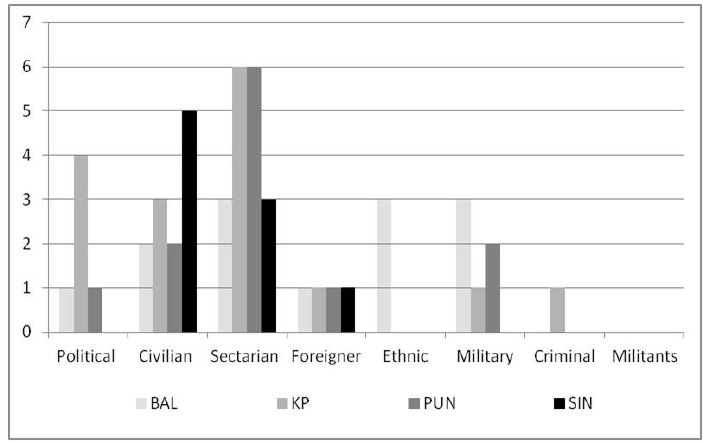
Figure 5. Number of Event–Target clusters for different Target Killing types.